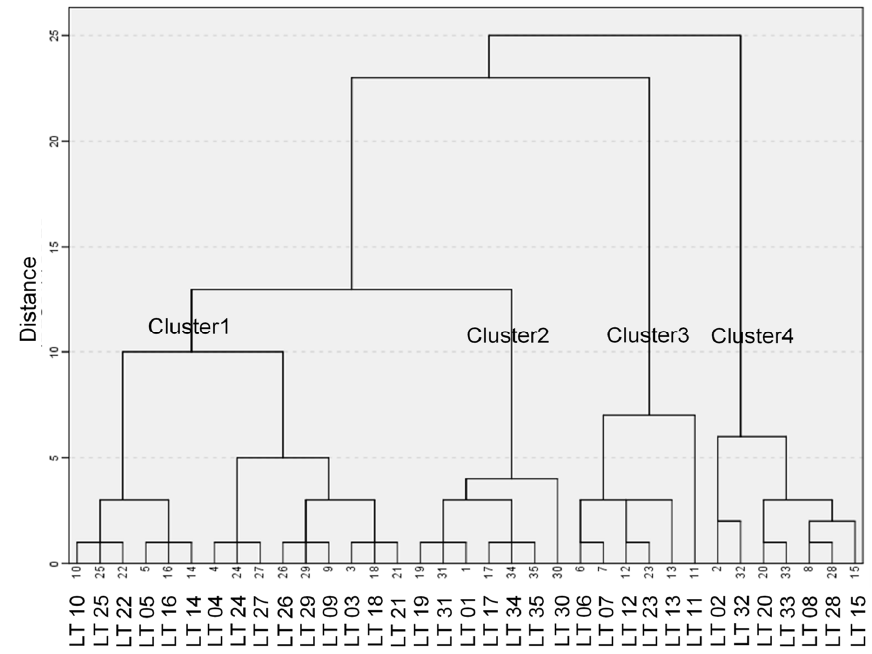
Figure 6. Dendrogram was exhibited by the cluster analysis of 35 tomato accessions based on the Euclidean distance using components factors 1 and factors 2 under LT